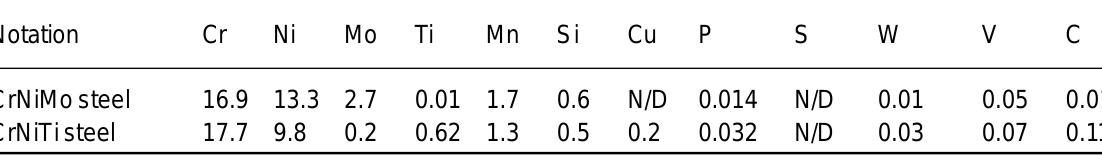
Table 1. Chemical composition of the steels (wt. %).